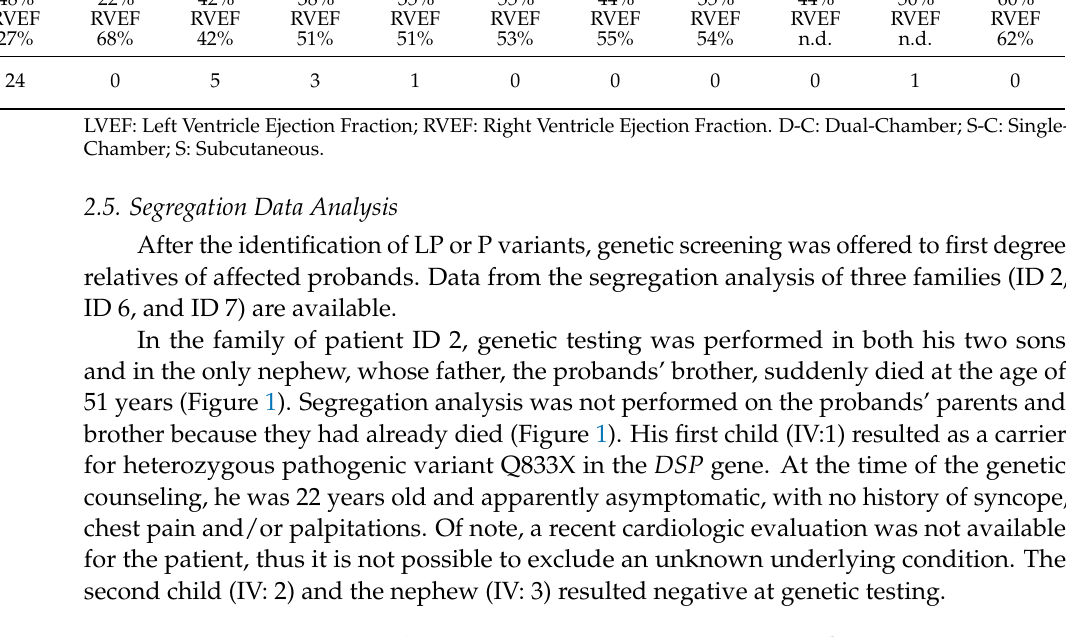
Table 5. Data related to implantable cardioverter defibrillator (ICD) implantation.